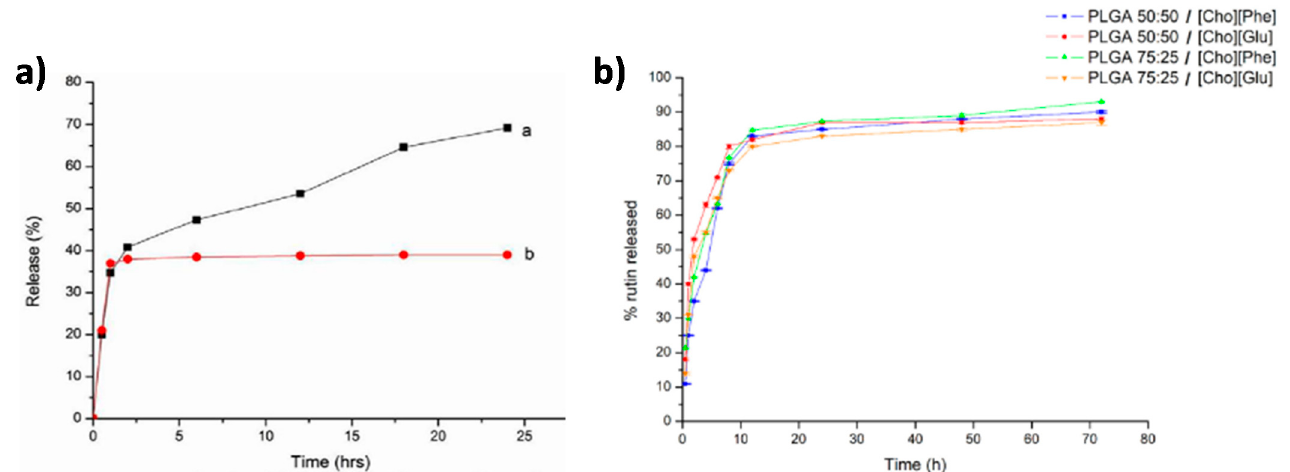
Figure 11. ( a ) In vitro release profile of a:5-FU loaded Ca- alginate/chitin nanofibers bio-nanocomposite gel beads and b: calcium alginate beads. Reprinted with permission from [122]. ( b ) Release profile of the rutin-loaded IL-PLGA nanoparticle hybrid systems during 72 h in phosphate buffer saline at pH 7.4. Data represented as mean ± SD ( n = 3). Reprinted with permission from [114].